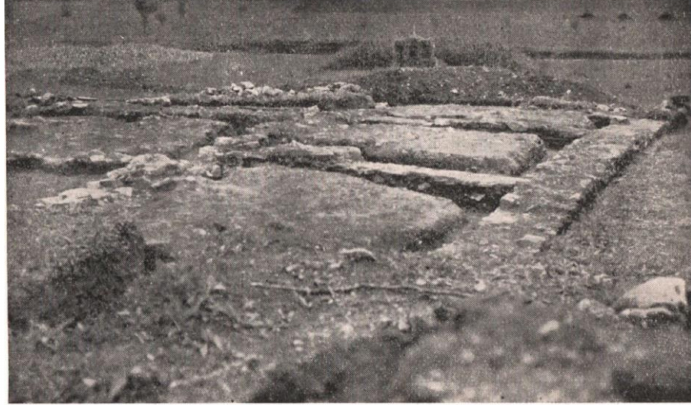
Figure 5. The temple dedicated to the Mauri Gods ( Dii Mauri ) ( ©